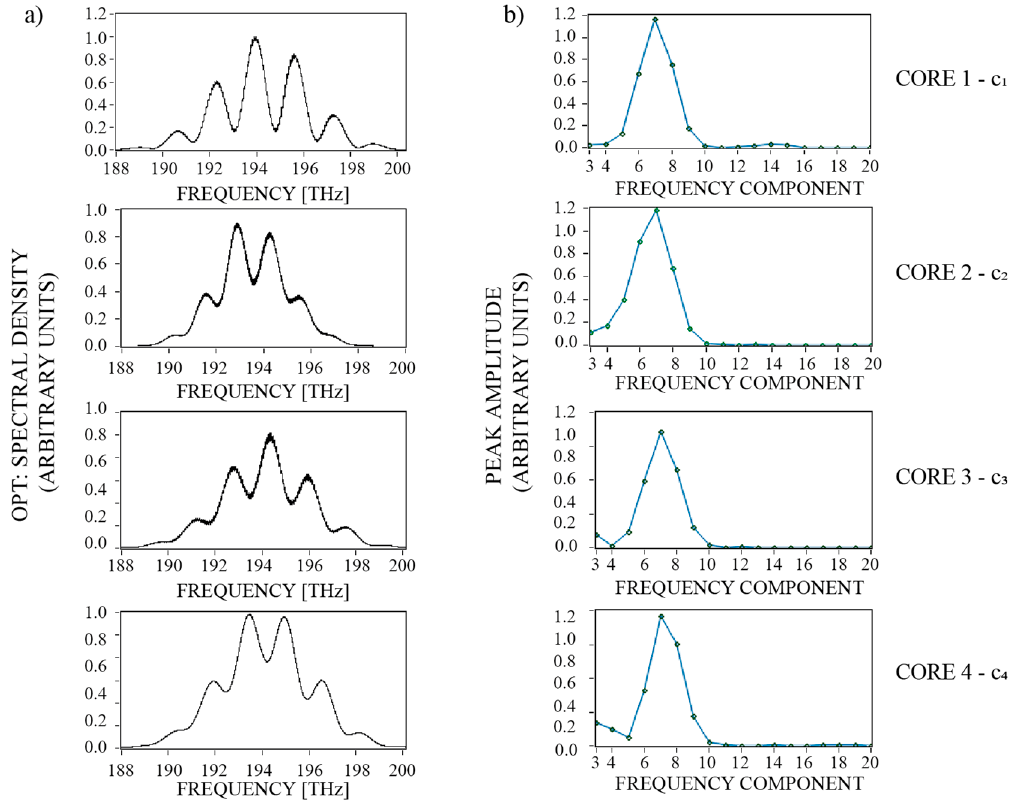
Figure 6. ( a ) Typical recorded optical back-reflected spectrum of FP interferometers (with applied Gaussian window) and ( b ) their amplitude (Fourier transform).